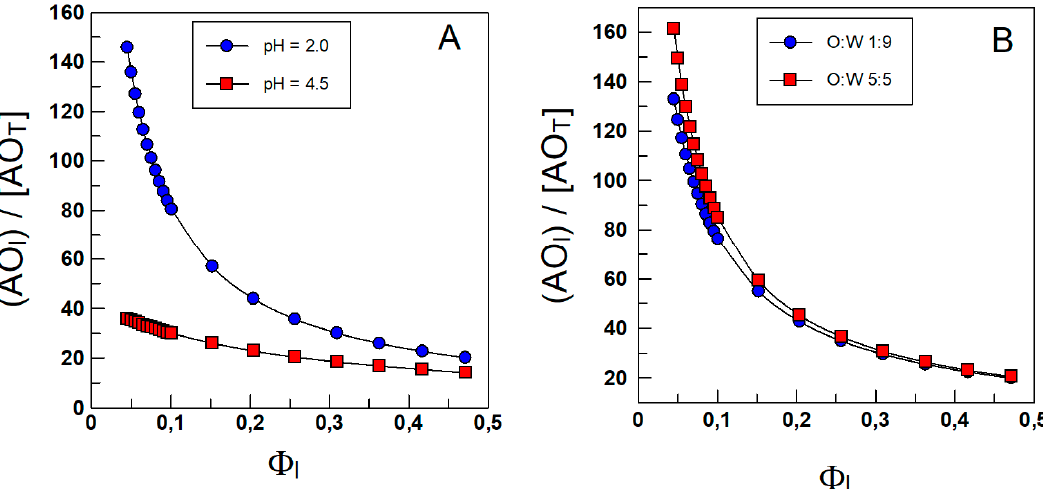
Figure 5. ( A ) Illustrative theoretical variations of the ratio (AO I )/[AO T ] with Φ I for gallic acid (pKa = 4.5) and partition constants of P WI = 300 at pH = 2 and P WI (app) = 30 at pH = 4.5. ( B ) Effects of the oil-in-water (o/w) ratio on the variation of the ratio (AO I )/[AO T ] with Φ I for gallic acid at pH = 2 ( P WI = 300). In both cases, theoretical (AO I )/[AO T ] values were obtained by employing Equation (16).